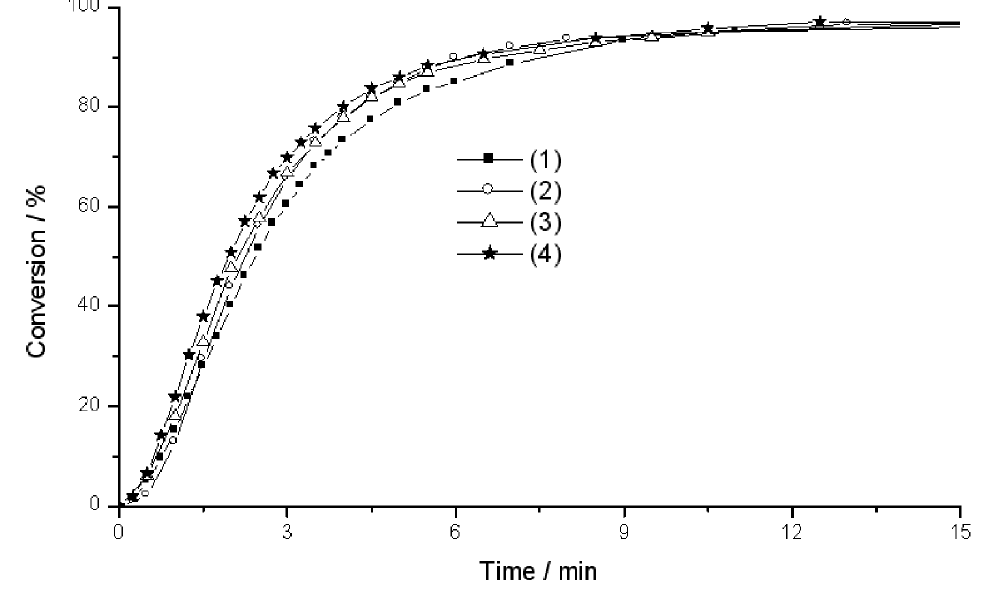
Fig. 1 Variation of monomer conversion in the inverse miniemulsion copolymerization of AAm with MBA concentration and reaction time. Recipe: 100 g cyclohexane, 35 g water, 5 g AAm, 15 g Tween 85, 0.104 g APS, 60 o C. [MBA] x 10 2 /mol.dm 3 : 1.87 (1), 5.56 (2), 9.27 (3), 12.97 (4). water (R ) and then slowly decreases up to the ¯nal p;max